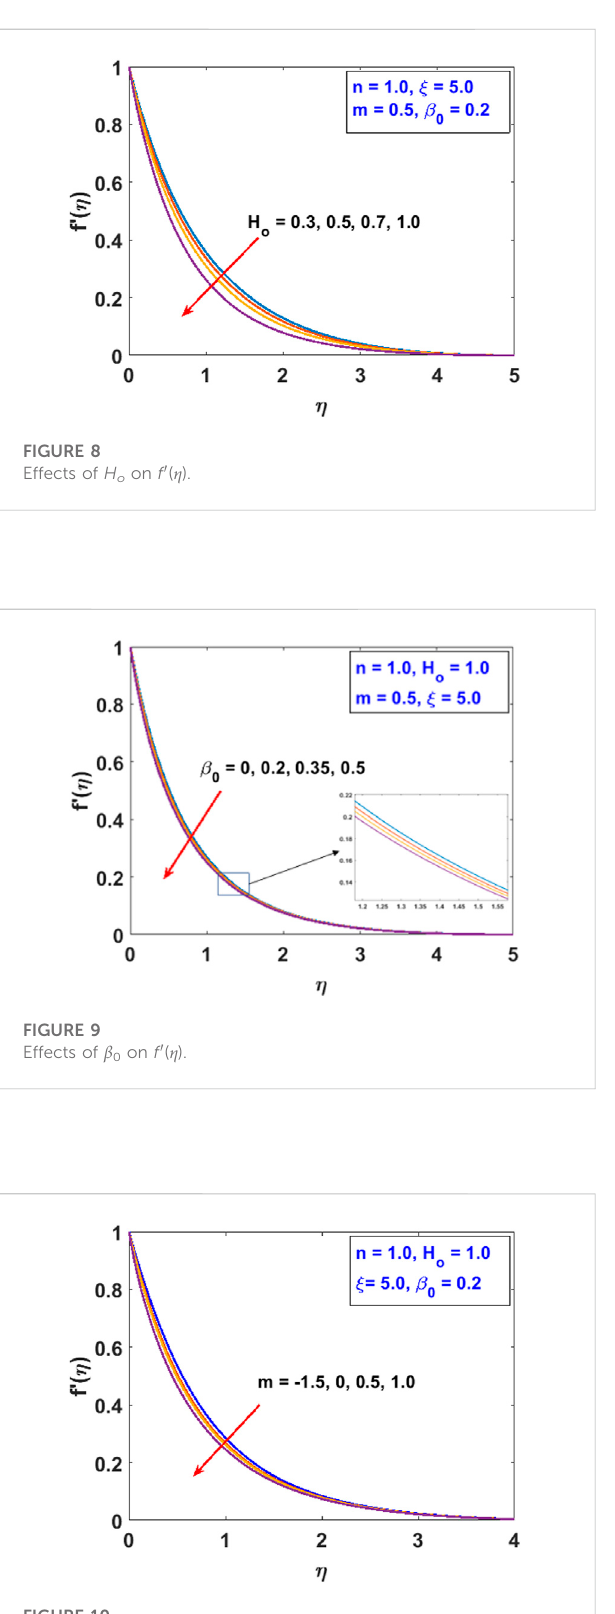
FIGURE 10 Effects of m on f ′ ( η